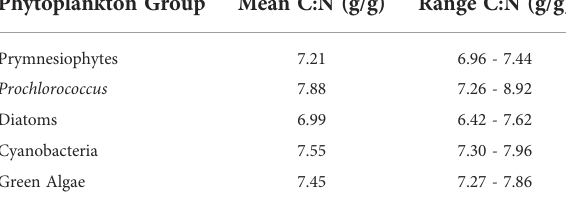
TABLE 3 Taxon-speci fi c mean and range of phytoplankton C:N. Phytoplankton Group Mean C:N (g/g) Range C:N (g/g)